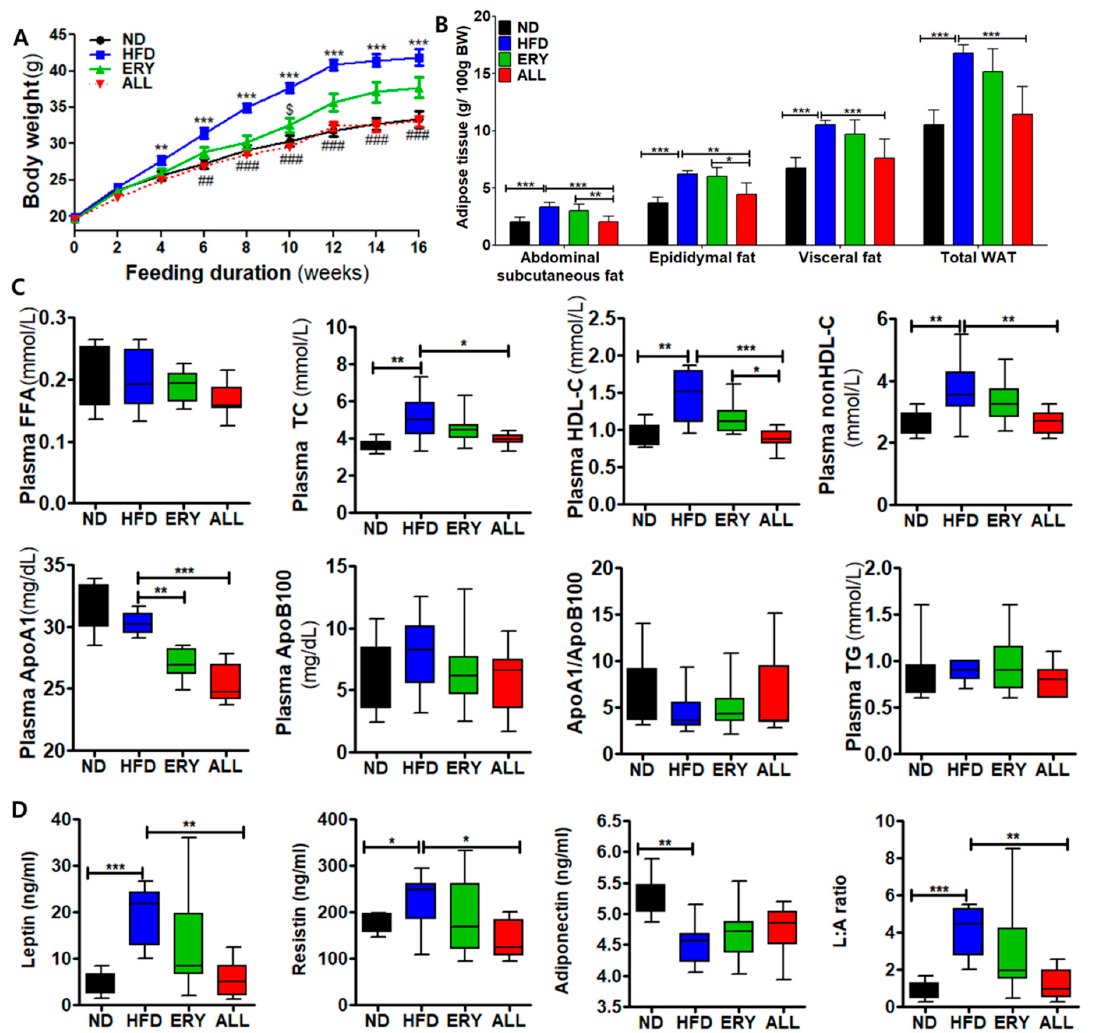
Figure 1. Effects of D-allulose supplement for 16 weeks, on body and adipocyte weights and plasma lipid levels, in C57BL / 6J mice fed a high-fat diet. ( A ) Body weight. ( B ) Adipocyte weights. ( C ) Plasma lipid levels. ( D ) Adipokine levels. Data are presented as the mean ± SE. Kruskal-Wallis test; * p < 0.05, ** p < 0.01, *** p < 0.001 versus control; ND, normal diet; HFD, high-fat diet (20% fat, 1% cholesterol); ERY (HFD + 5% Erythritol); ALL, (HFD + 5% D-allulose); FFA, free fatty acid; TC, total cholesterol; HDL-C, high-density lipoprotein cholesterol, ApoA1, apolipoprotein A1; ApoB, apolipoprotein B; non-HDL-C = (TC) – (HDL-C), L:A ratio, leptin: adiponectin ratio.